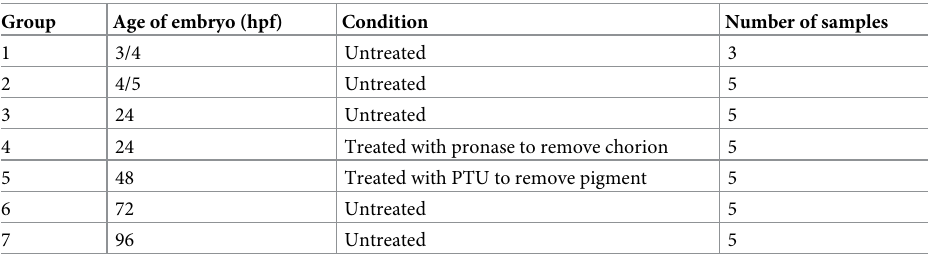
Table 1. Sample groups used for